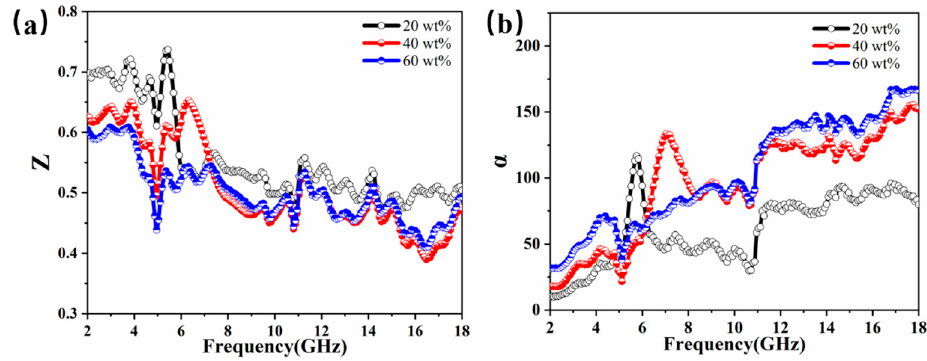
Figure 8. Frequency dependence of ( a ) impedance matching Z and ( b ) attenuation constant α for CIP@MnO 2 composites with different filling ratios.